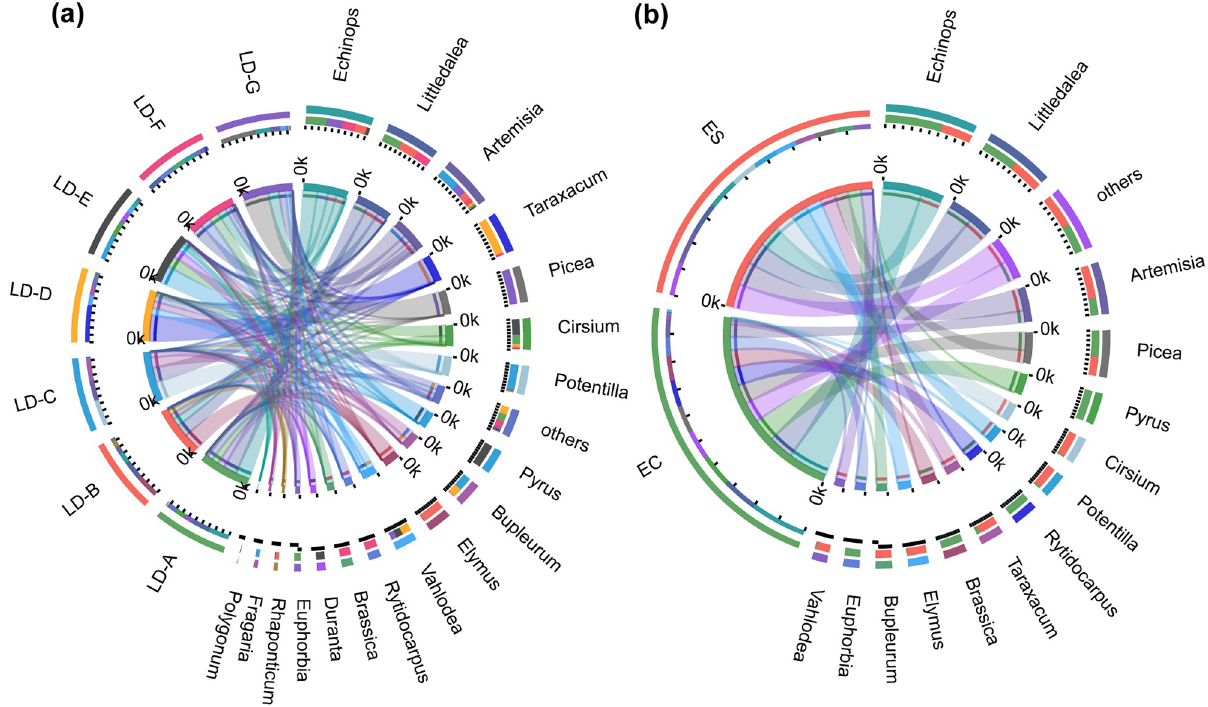
Fig 4. Circos diagram of zokor diet at the genus level among zokors in different study areas and interspecies. Genera with %RA < 5% are classified as others.